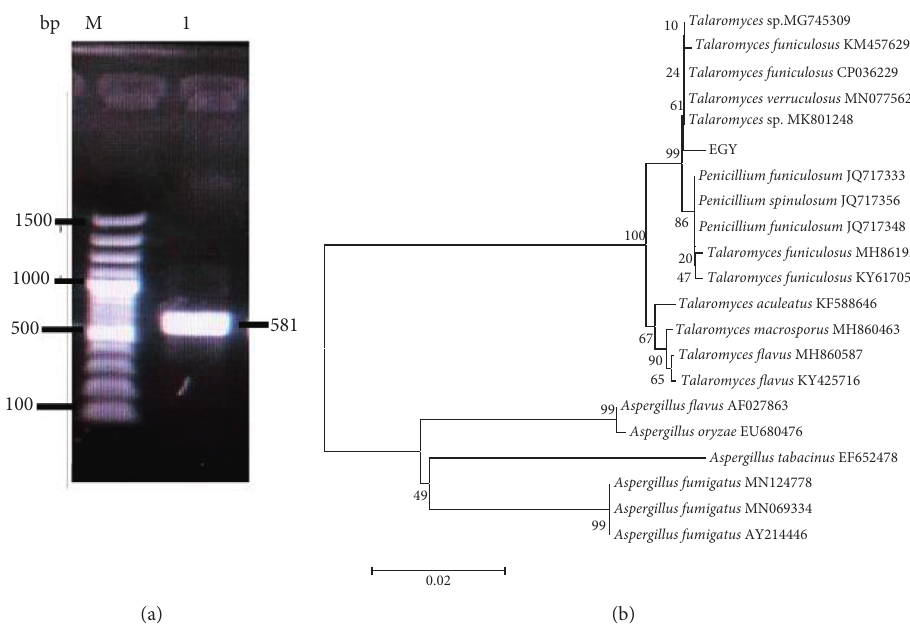
Figure 1: Molecular identification of dextranase-producing strain ( Talaromyces sp.) based on ITS region sequence analysis. (a) PCR amplification of DNA of the fungal strain (EGY) using universal primers (ITS1/ITS4). Lane 1: PCR products were resolved by 1% agarose gel electrophoresis. M: 100bp DNA ladder (Thermo ScientificGeneRuler 100bp Plus). (b) Phylogenetic tree based on ITS rRNA gene